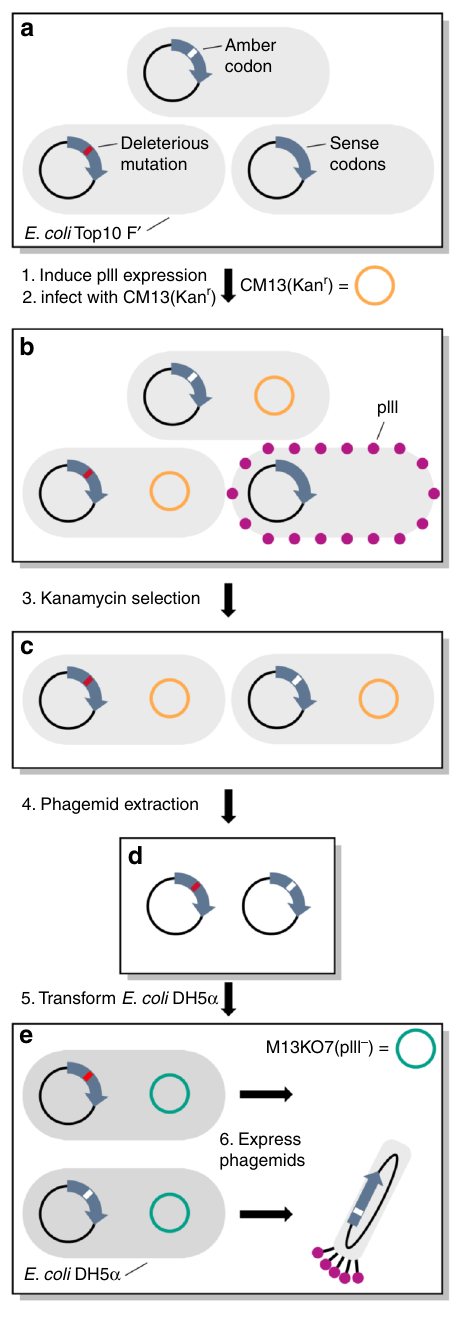
Fig. 2 A schematic representation of a method for constructing an amber-obligate phage display library by superinfection-immunity-based selection. a , b Following cloning, the naive phagemid library is used to transform non-amber-suppressing E. coli bearing an F sex pilus. The expression of pIII is induced with IPTG, and shortly after, cells are superinfected with the CM13 helper phage ( a ). The expression of pIII in cells harboring a copy of the library that contains only sense codons renders these cells immune to superinfection ( b ). c Changing the media to one containing kanamycin allows for the selective growth of cells harboring a copy of the library that contains in-frame amber codons. Cells harboring a copy of the library with deleterious mutations also pass this selection. d , e The phagemid library is puri fi ed ( d ) and used to transform DH5 α , an amber-suppressing strain of E. coli ( e ). Complementation of the phagemid with a pIII-knockout helper phage in E. coli DH5 α allows for the production of phagemid particles only from cells harboring a copy of the peptide-pIII library containing in-frame amber